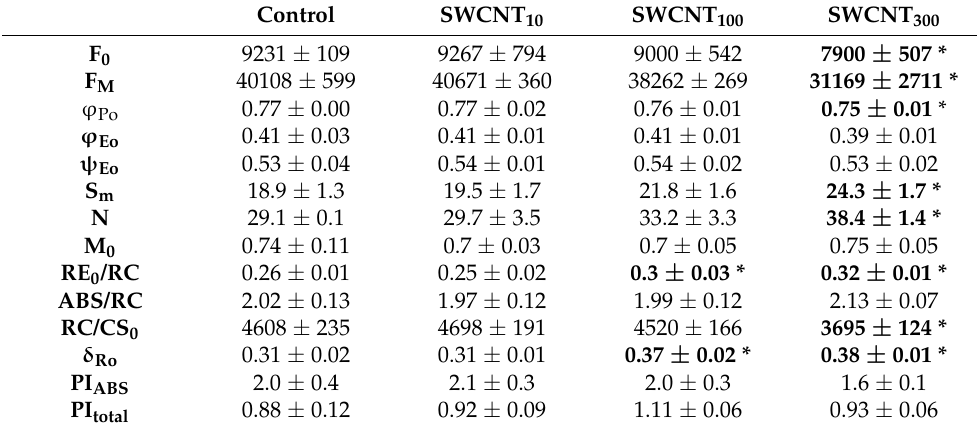
Table 1. Mean values of selected JIP test parameters for intact pea leaves treated with 10, 100 or 300 mg/L polymer-grafted SWCNT.